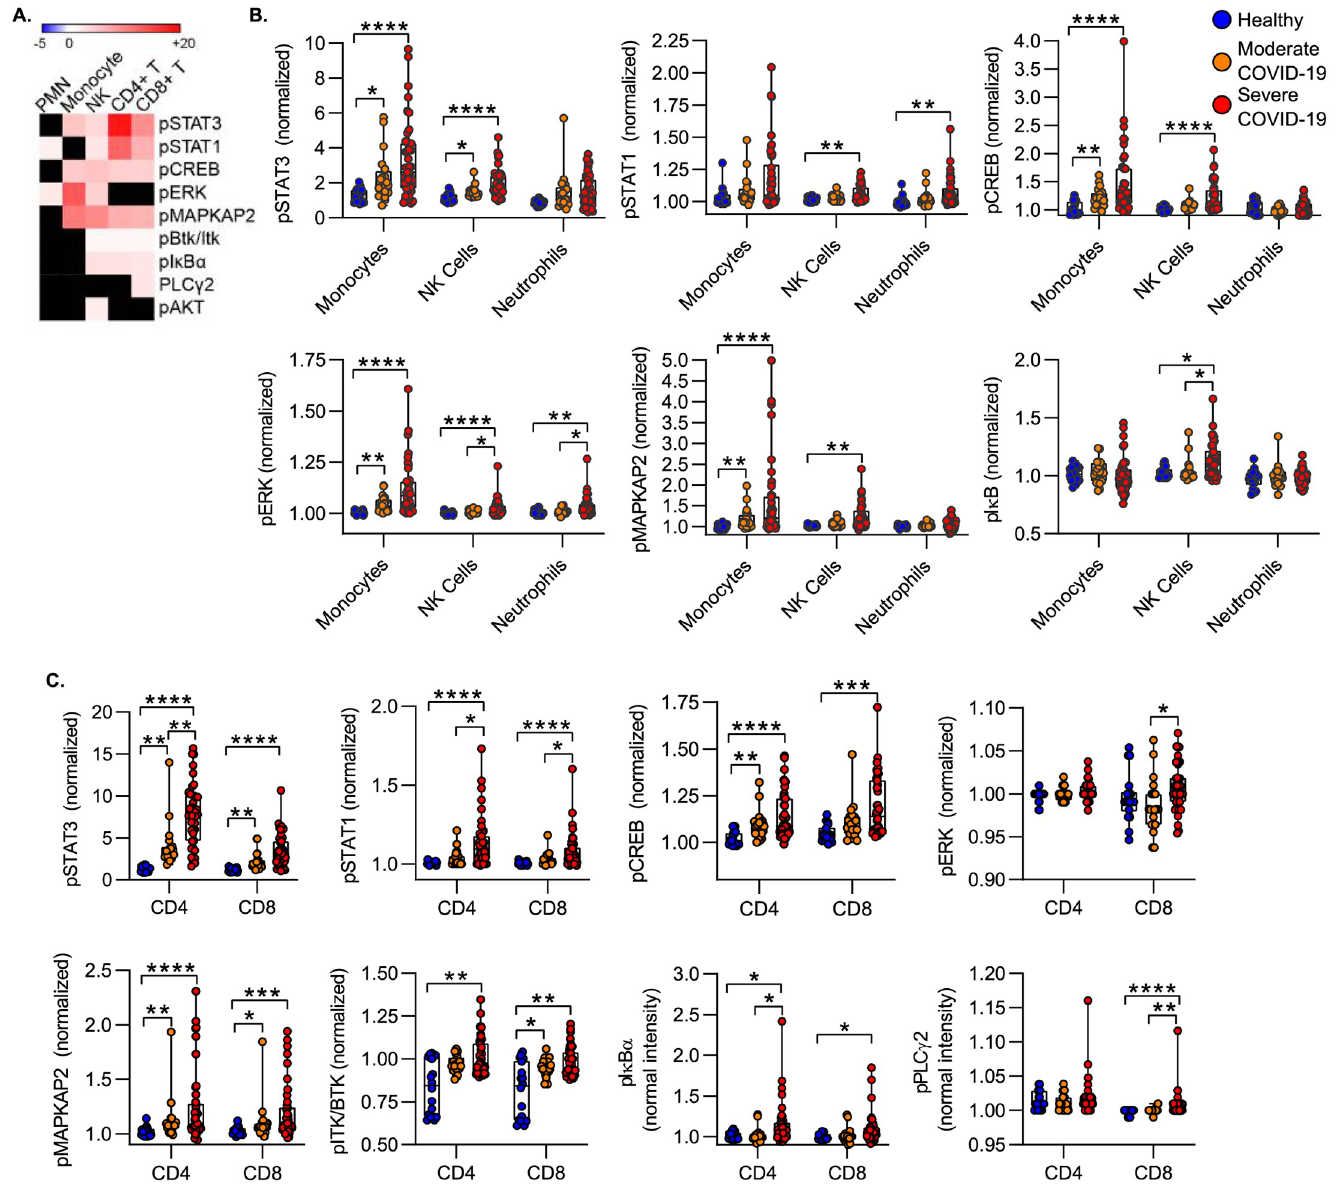
Fig 4. Effect of COVID-19 on circulating leukocyte phosphoproteome. A) Heat map of effect size of severe COVID-19 vs. healthy controls. Effect size defined as difference of means of severe COVID vs. healthy, divided by standard deviation of healthy. Black squares are features which are not significantly different. B-C) Phosphoprotein levels in innate (B) and adaptive (C) leukocytes. To correct for CyTOF batch effects, all signal intensities are normalized to a common reference control and shown as fold-change of the reference control. Box plots represent 25-75 th percentile with line defining group median, with all data-points overlying. Error bars extend from minimum to maximum values. � p < 0.05, �� p < 0.01, ��� p < 0.001, ���� p < 0.0001 by Dunn’s multiple comparisons test after nonparametric (Kruskal- Wallis) ANOVA with correction FDR < 1% (Benjamini, Krieger and Yekutieli). between severe COVID-19 and healthy controls, divided by the standard deviation in the con- trol population. Fig 4 is a heatmap of the signaling effect size induced by severe COVID vs. healthy control (black squares are features which did not reach a statistically significant thresh- old). Overall, COVID-19 was associated with wholesale increases in signaling phosphoprotein levels. Consistent with hierarchical clustering data, we measured the largest effect sizes measured